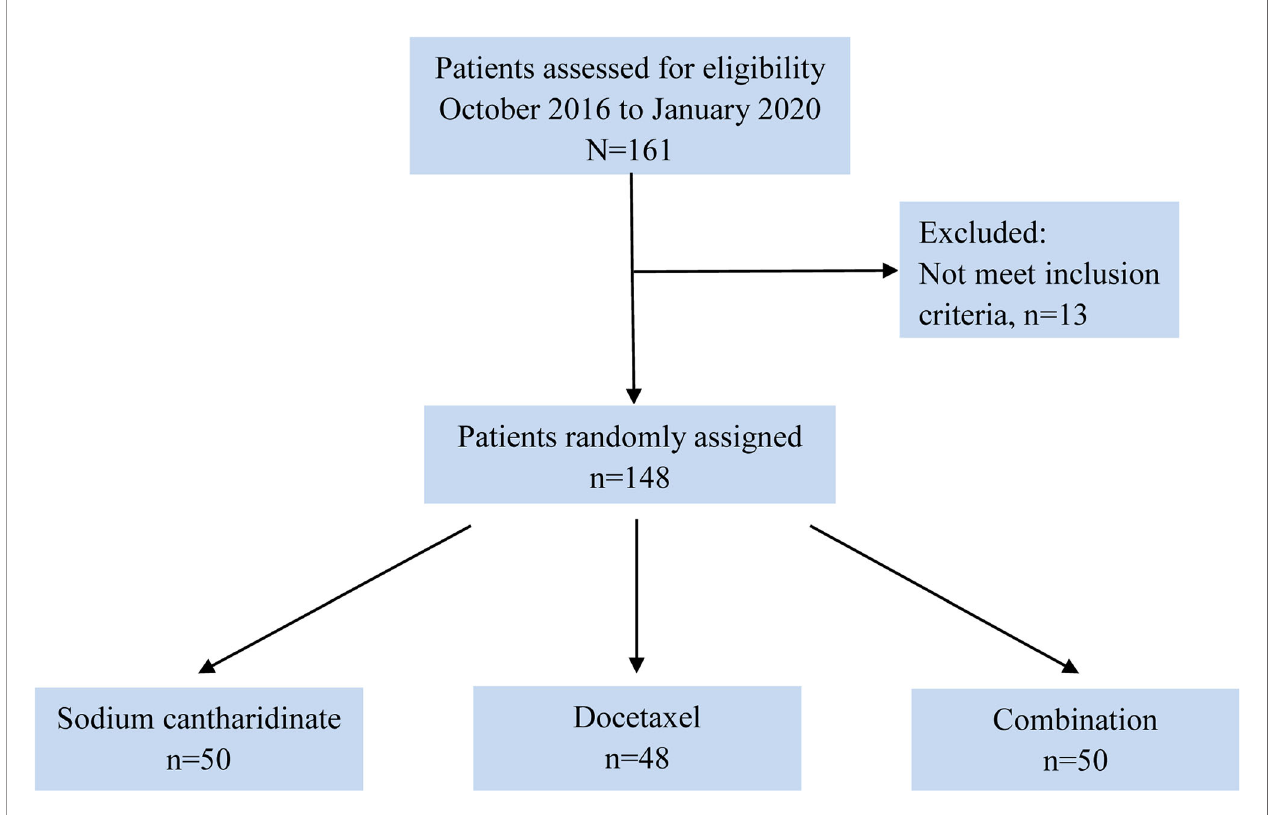
FIGURE 1 | Flow diagram of patient